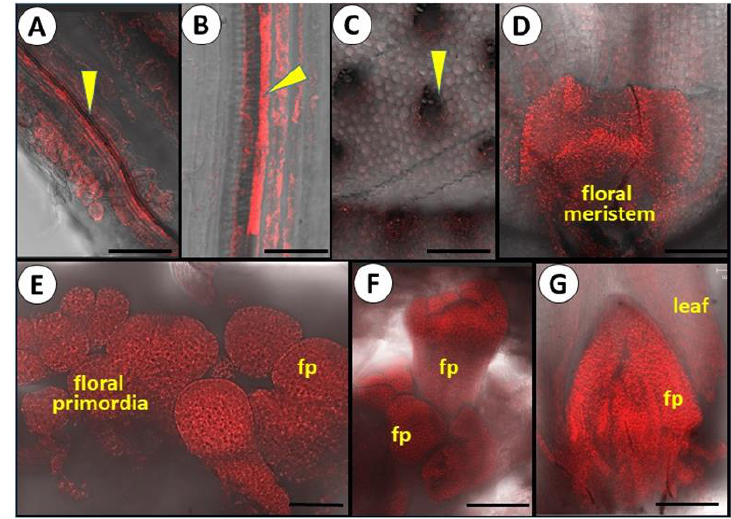
Figure 4. Microphotographs of FISH analysis of potyviruses spatial distribution in vegetative and reproductive tissues of fertile garlic accession. February/March 2022. Scale: A, B = 35 µm; C, F, G = 200 µm; D = 250 µm; E = 150 µm. ( A ) First seedling true leaf. Both phloem (arrow) and parenchyma are infected. ( B ) Young foliage leaf originated from the bulb clove. The phloem vascular tissue (arrow) is infected by potyviruses. ( C ) Cross-section of floral scape. The phloem vascular bundles (arrow) are infected. ( D ) Floral meristem, initiation stage, infected by potyviruses. ( E ) Differentiation of floral primordia (fp) infected by potyviruses. ( F ) Infected differentiating flower primordia; ( G ) Infected differentiated young flower.